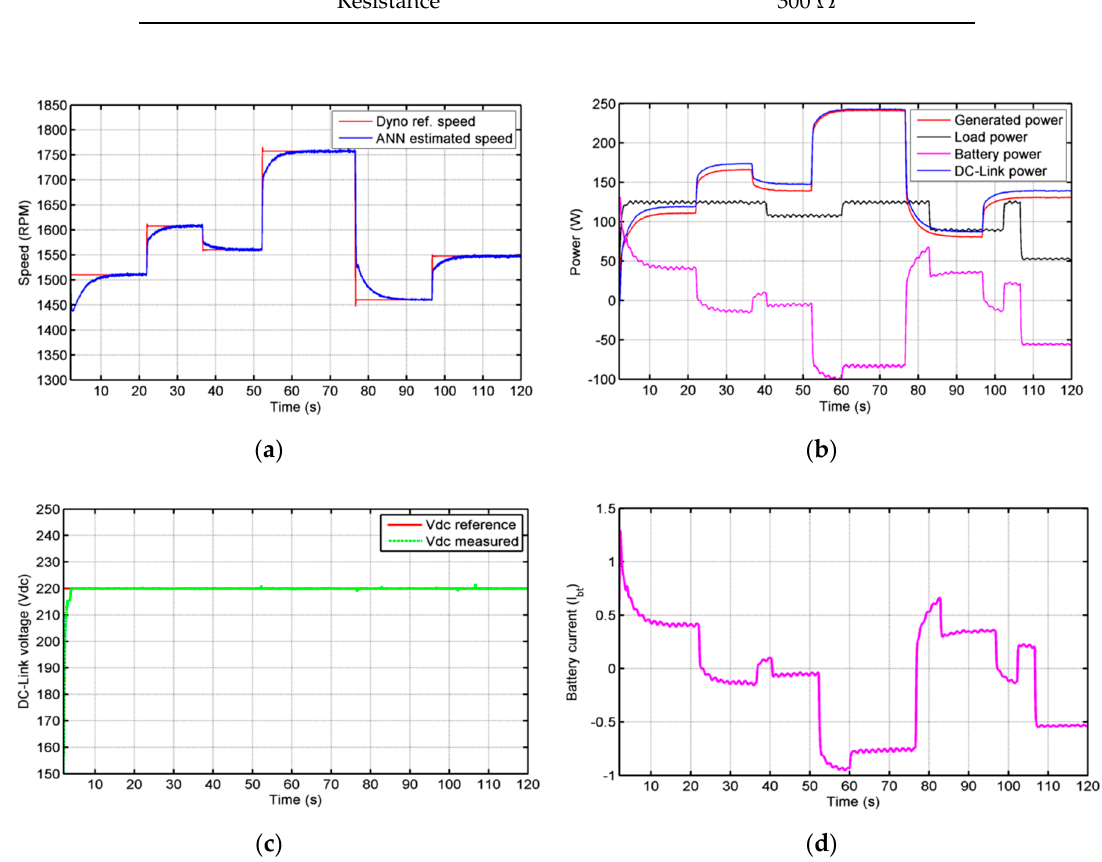
Figure 9. Control and estimation responses under variable step wind speed profile and variable load: ( a ) Speed estimation and tracking; ( b ) power responses; ( c ) DC-link voltage regulation; ( d ) battery current.